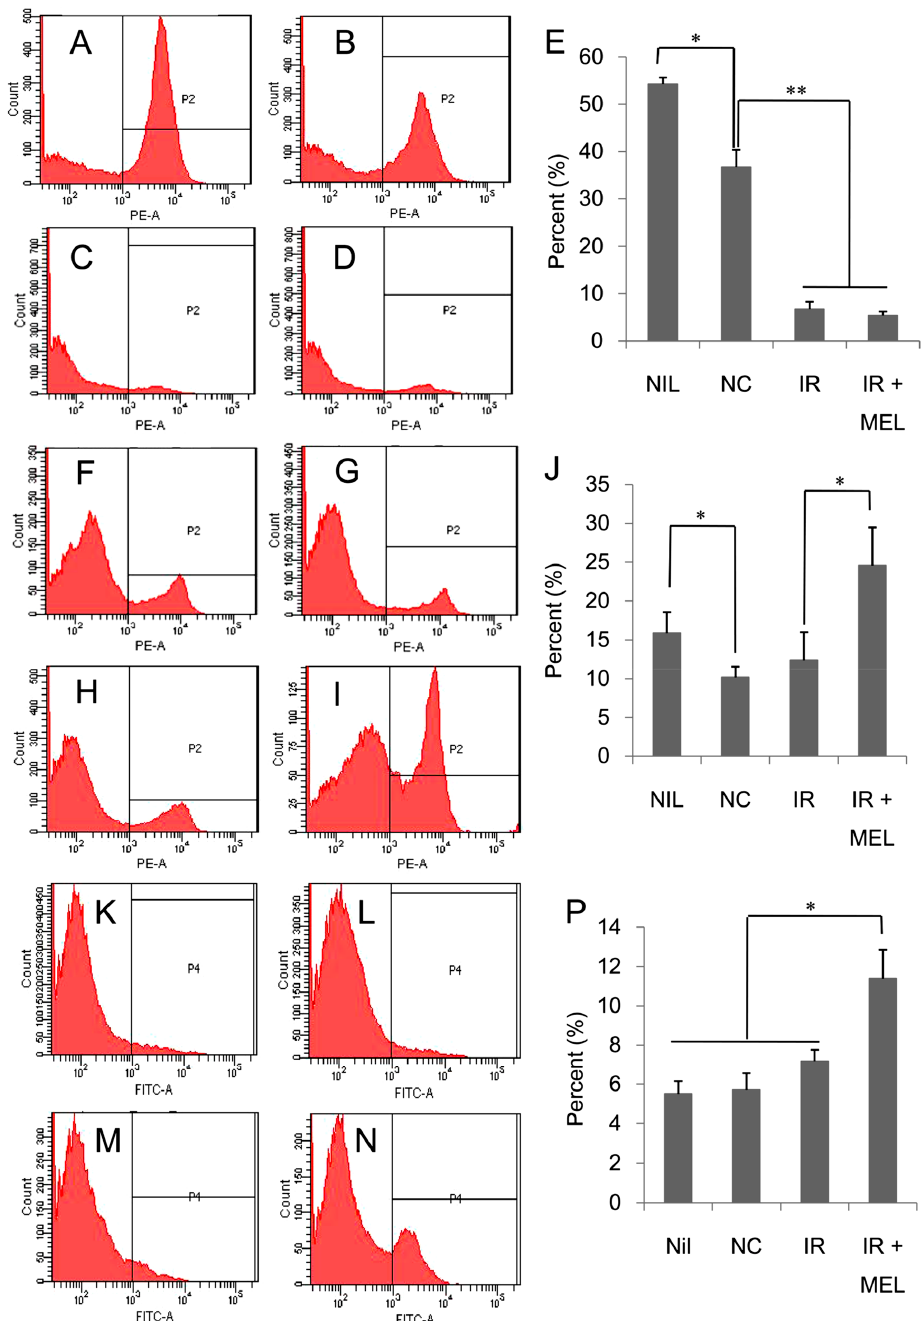
Figure 7. Populations of B cells in spleens of mice in the NIL ( A ), NC ( B ), IR ( C ), and IR + MEL ( D ) treatment groups determined by flow cytometry. Percentages of populations of B cells in each group are presented as histograms ( E ). Populations of T cells in spleens of mice in NIL ( F ), NC ( G ), IR ( H ), and IR + MEL ( I ) treatment groups determined by flow cytometry. Percentages of populations of T cells in each group are presented as histograms ( J ). Populations of dendritic cells in spleens of mice in NIL ( K ), NC ( L ), IR ( M ), and IR + MEL ( N ) treatment groups determined by flow cytometry. Percentages of populations of DC cells in each group are presented as histograms ( P ). NIL, mice with no induction of tumor or treatment; NC, mice receiving no treatment; IR, mice treated with a single dose of X-ray radiation; IR + MEL, mice treated with 40 mg / kg nanomelanin once before X-ray radiation and again 2 days post-radiation. *, **: significant di ff erences with P < 0.05 and P < 0.01, respectively, from the control by the Student’s t